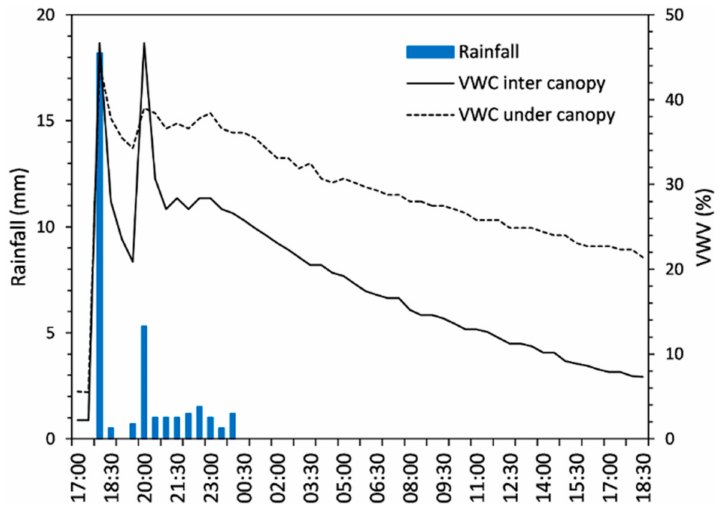
Figure 6. Soil moisture behavior inter canopy and under canopy for one rainfall event (29 mm) on 10 July 2018, in micro-catchment 1.